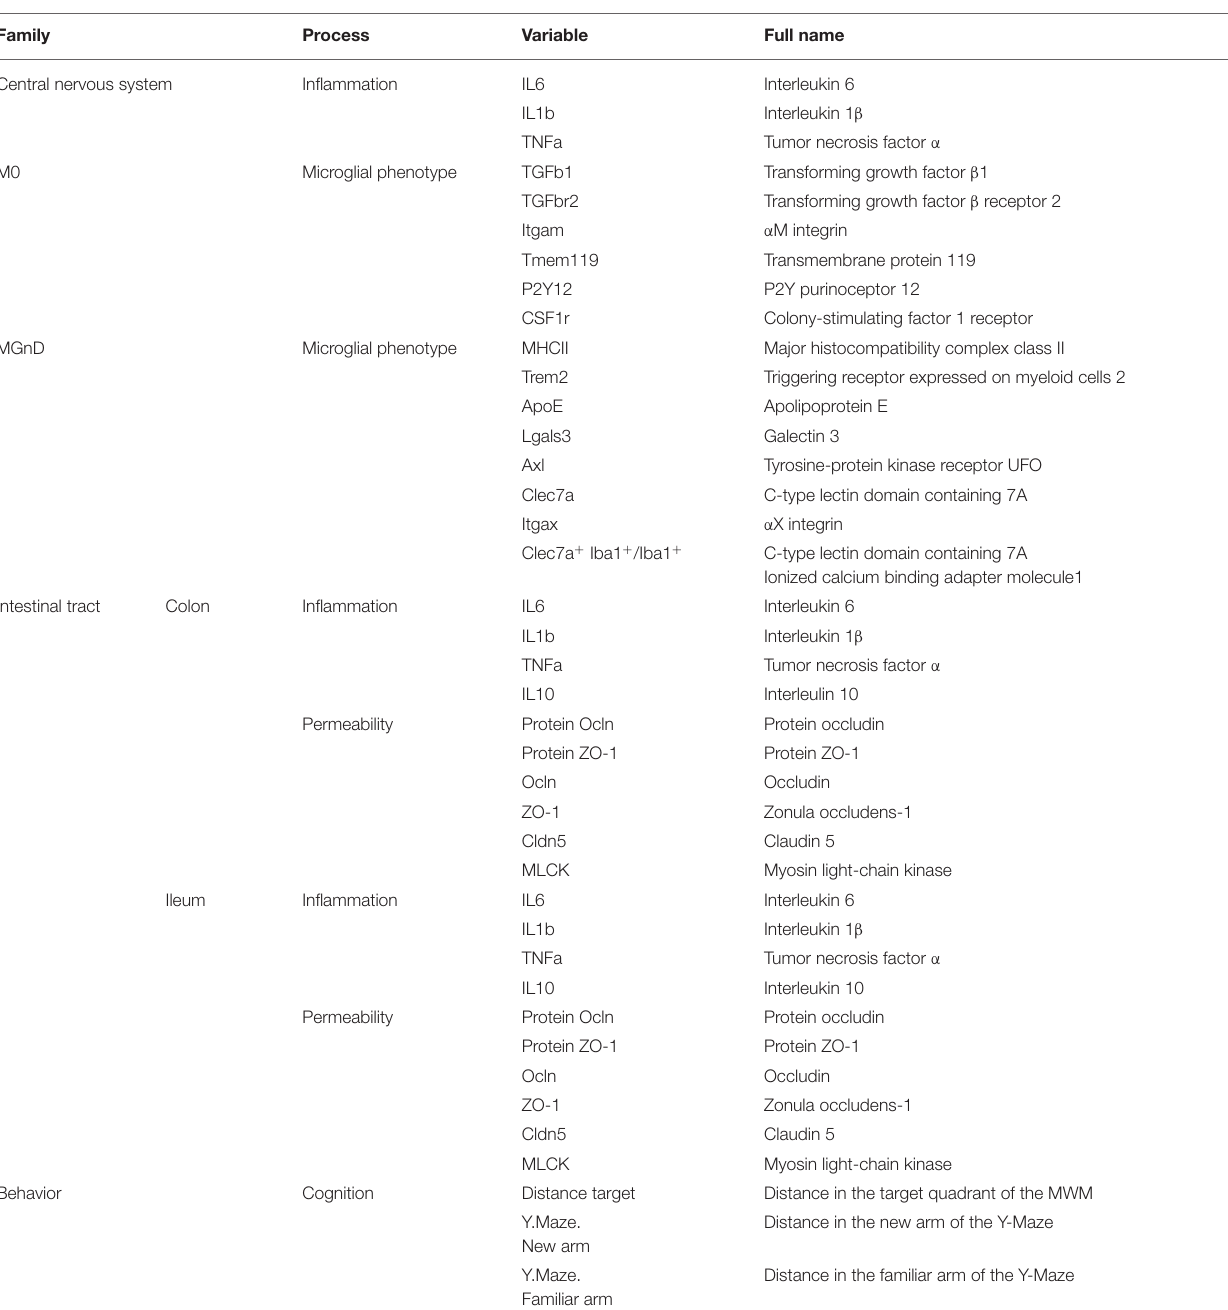
TABLE 2 | Variables used for hierarchical cluster